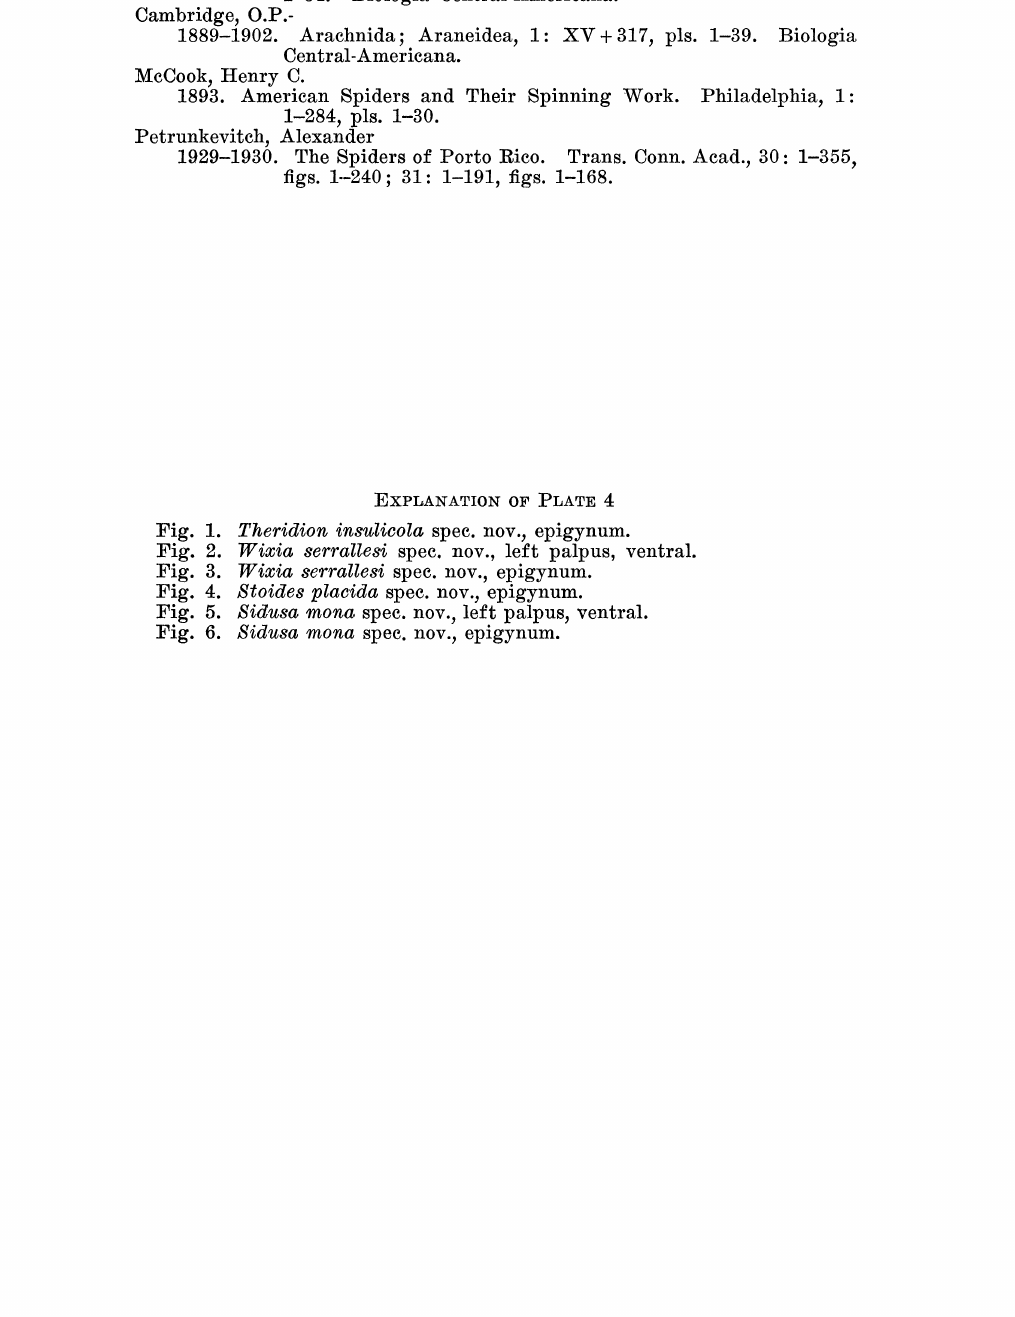
Fig. 1. Theridion insulicola spec. nov., epigynum. Fig. 2. Wixia serrallesi spec. nov., left palpus, ventral. Fig. 3. Wixia serallesi spec. nov., epigynum. Fig. 4. Stoides placida spec. nov., epigynum. Fig. 5. Sidusa mona spec. nov., left palpus, ventral. Fig. 6. Sidusa mona spec. nov.,